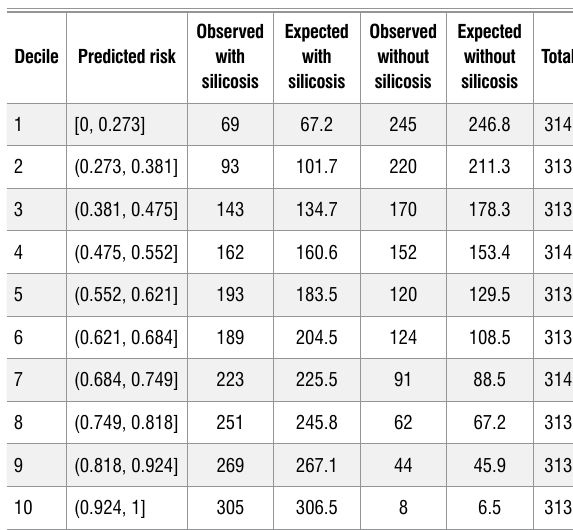
Estimated model accuracy by risk threshold (Modelling group, 361 deceased claimants)